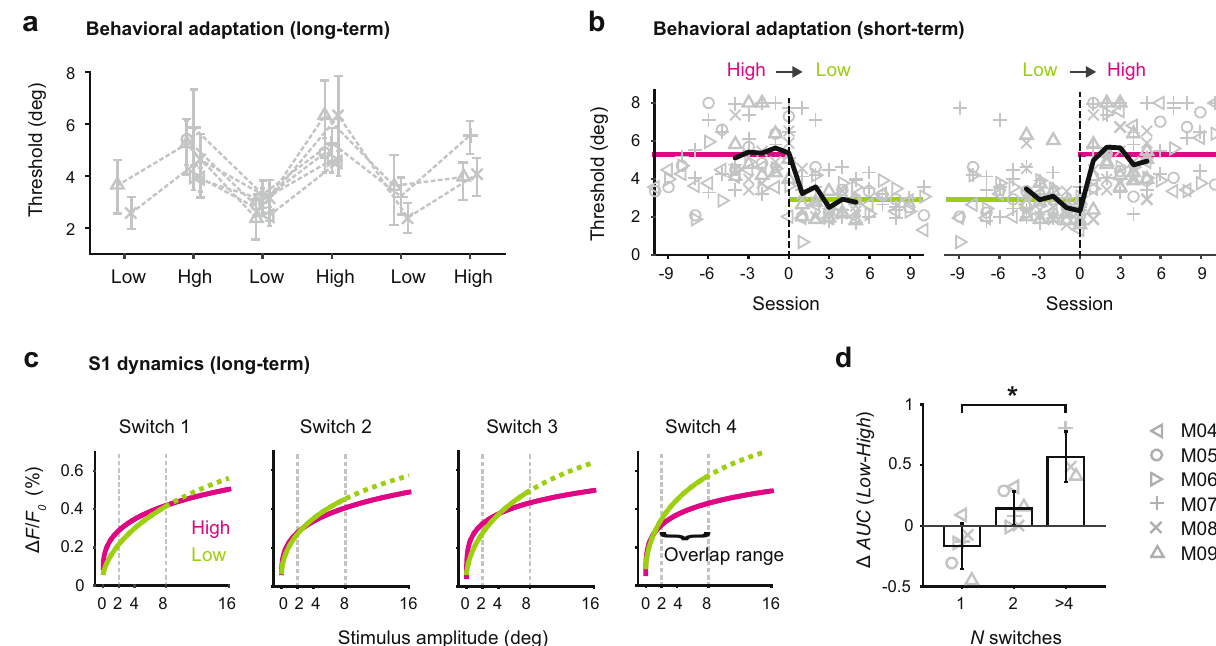
Fig. 4 Timescale of behavioral adaptation and related S1 dynamics. a Long-term behavioral adaptation. Psychometric thresholds of individual mice ( n = 6) undergoing repetitive task changes starting with either the high range or low range condition. Symbols represent mean thresholds across sessions ( n = 5 – 11 per condition), error bars represent 95% con fi dence limits. Conditions are changed in an alternating fashion to test reversibility of adaptation. b Short- term behavioral adaptation at the transition (dashed lines) from high to low (left) and low to high (right). Symbols represent thresholds from each mouse and each session. Bold lines represent thresholds averaged across mice before and after the transition. Horizontal lines represent thresholds averaged across mice and sessions for a given condition. The data are normalized with regard to the transition, with session 0 representing the last session of the preceding condition. c S1 dynamics over multiple task changes (long-term). Neuronal stimulus-response curves derived from the Δ F / F 0 measurement in S1. The curves are weibull fi ts to the data of n = 3 mice undergoing repetitive changes. The “ overlap range ” is de fi ned as the stimulus range common to both high range and low range datasets (2 – 8 degree) which is used to calculate the area under the curve (AUC). The hypothetical part (above 8 degree for the low range) is represented as dashed curve. d Difference between high range and low range S1 responses, calculated as the difference in AUC space ( Δ AUC (Low − High)) at different training stages. Bars represent means across mice with SD (not all mice underwent all switches; switch 1 – 2, n = 6 mice, switch >4, n = 3 mice). * P = 0.04, Kruskal – Wallis